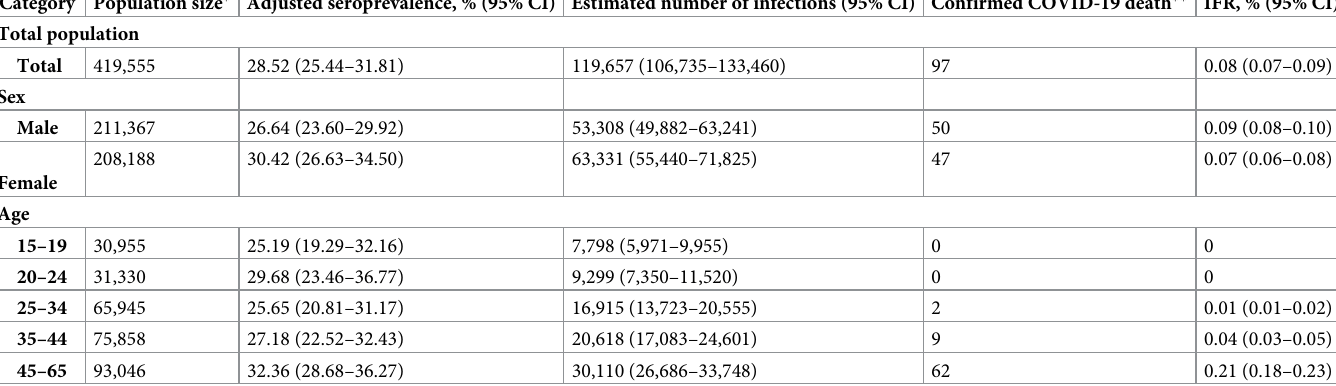
Table 4. The estimated